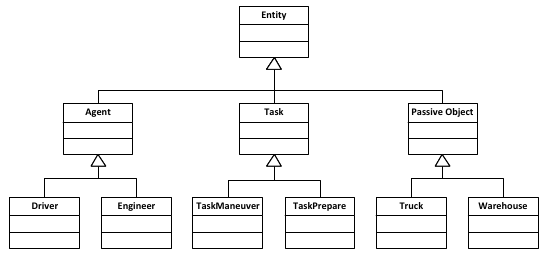
Figure 3. A Part of Entity Meta Model